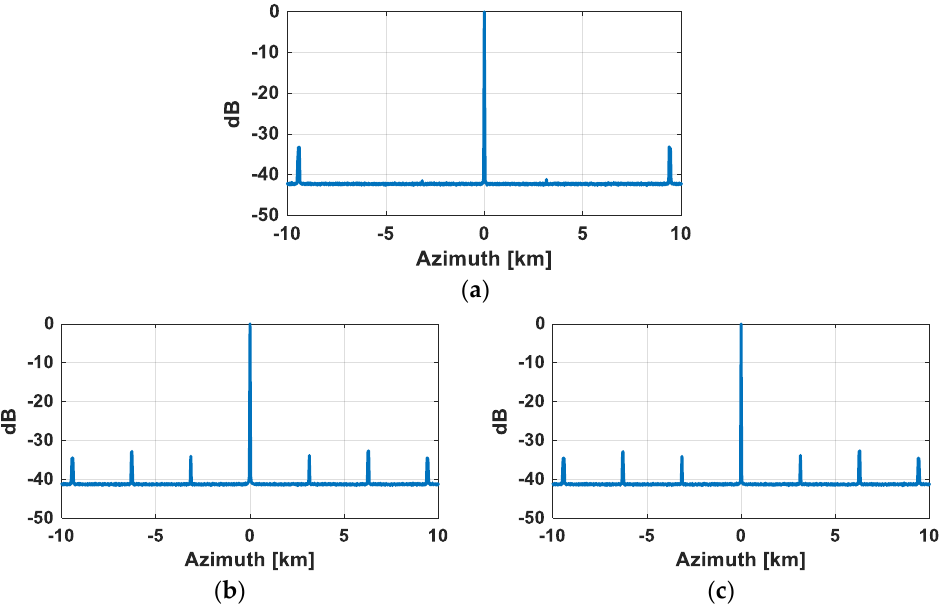
Figure 11. Plots of the energy of the target located at 4.28 ms, in Figure 9, integrated over three resolution cells in azimuth and all over range. The three cases correspond to the ideal anti-DPCA sensor spacing ( a ), and to the realistic condition where the second and third sensors are furtherly shifted along-track by 50 cm and − 50 cm, ( b , c ). ( b ) This refers to the traditional method and ( c ) to the proposed approaches, as defined in Figure 2.